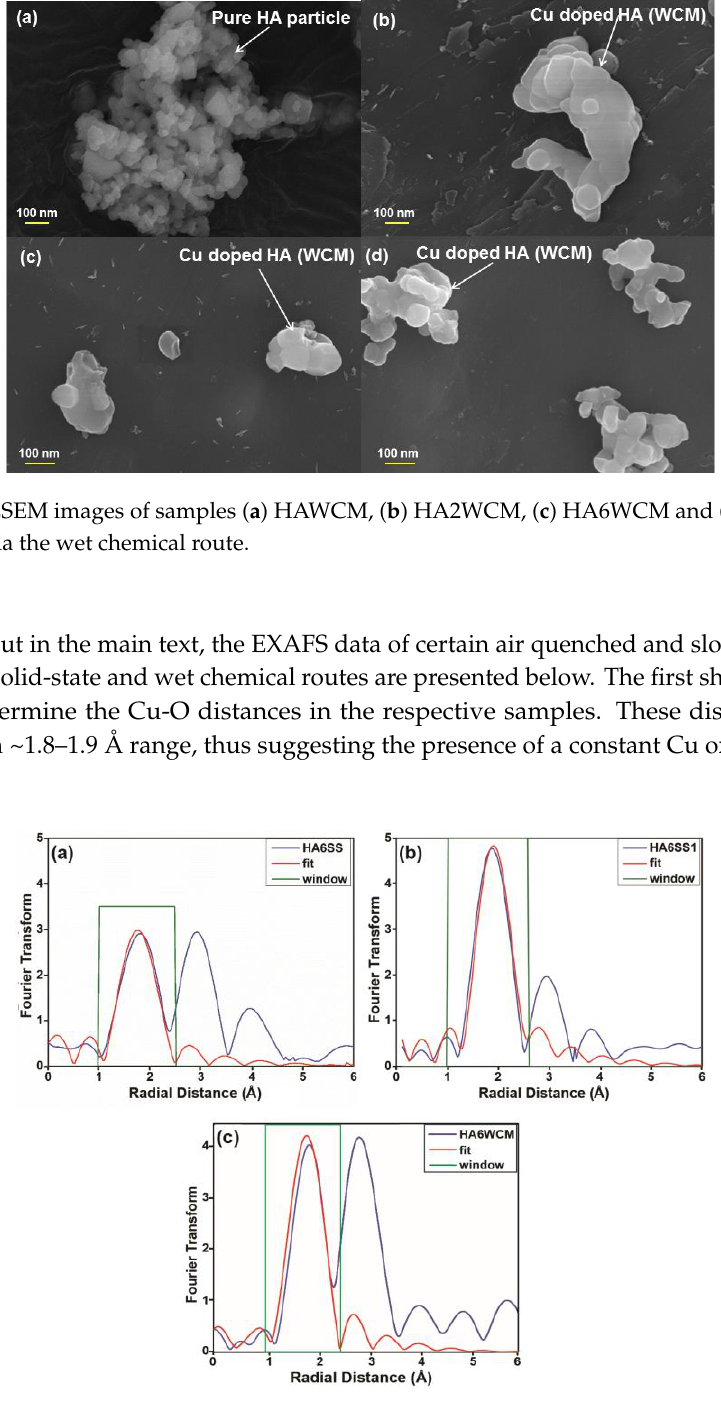
Figure A3. 1 st shell EXAFS data from ( a ) the air-quenched sample HA6SS obtained from the solid-state reaction route, ( b ) the slow cooled sample HA6SS1 obtained from the solid-state reaction route and ( c ) the air quenched sample HA6WCM obtained from wet chemical reaction route.